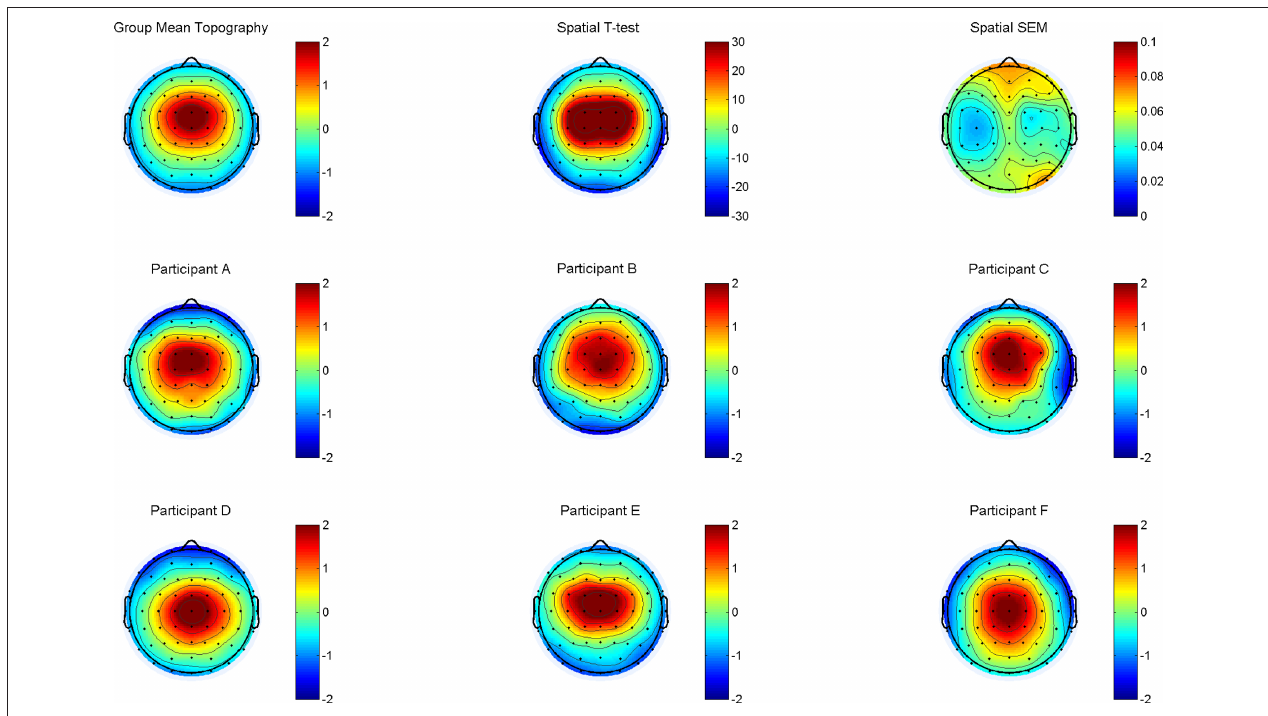
corresponding map of the standard error of the mean (SEM) illustrate the robustness of the selected topography in the sample. The middle and bottom rows (participants A–F) provide six randomly drawn single subject